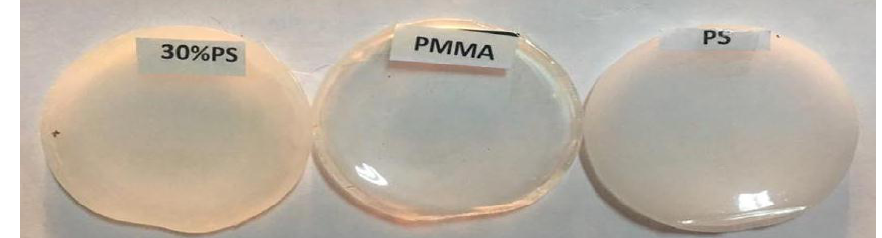
Fig.2: The samples of (PMMA, PS and 30%PS\PMMA). Table 1: Weight ratios (%) and thickness of polymer blends.